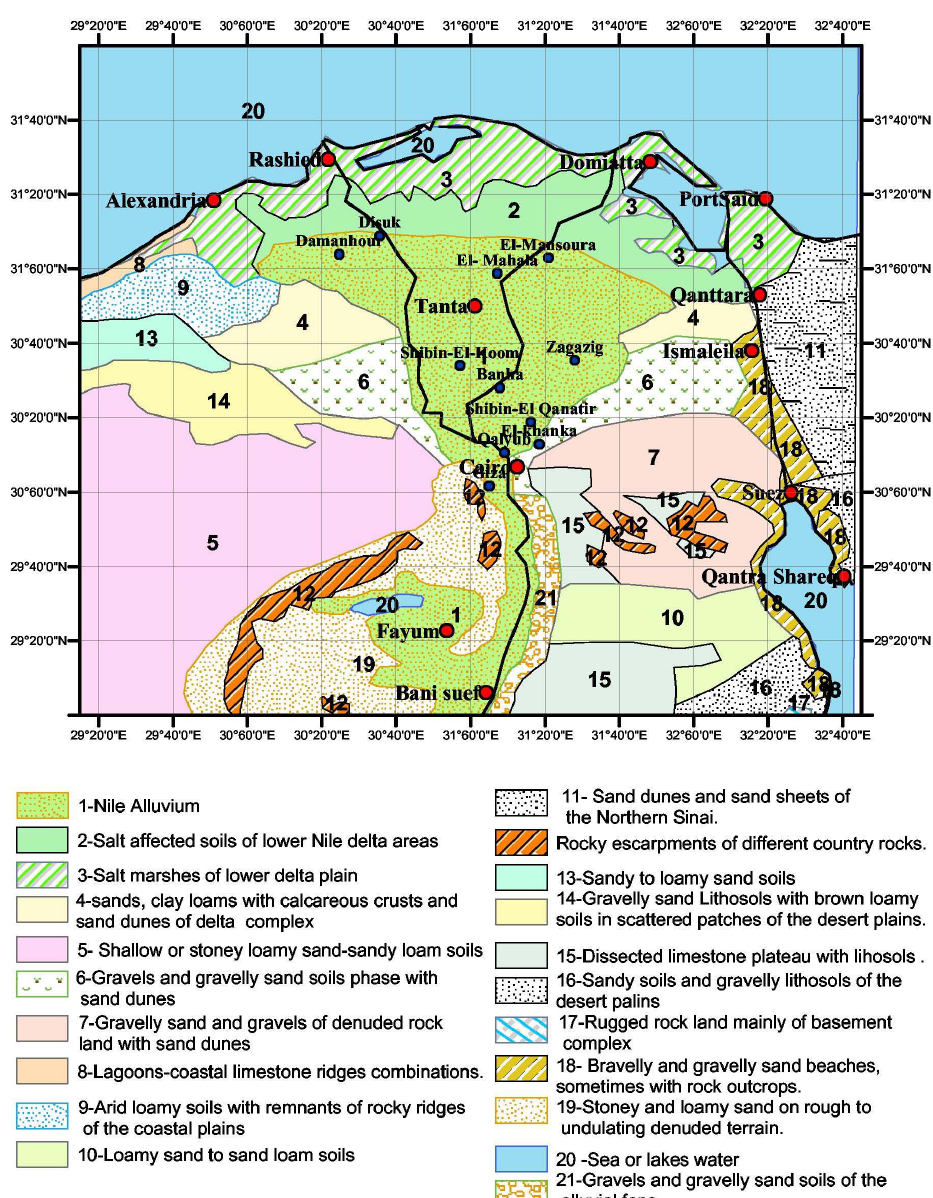
Fig. 2. Map of Surface geology in and around Greater Cairo Area (scale 1:500000, EGSMA, 1983).